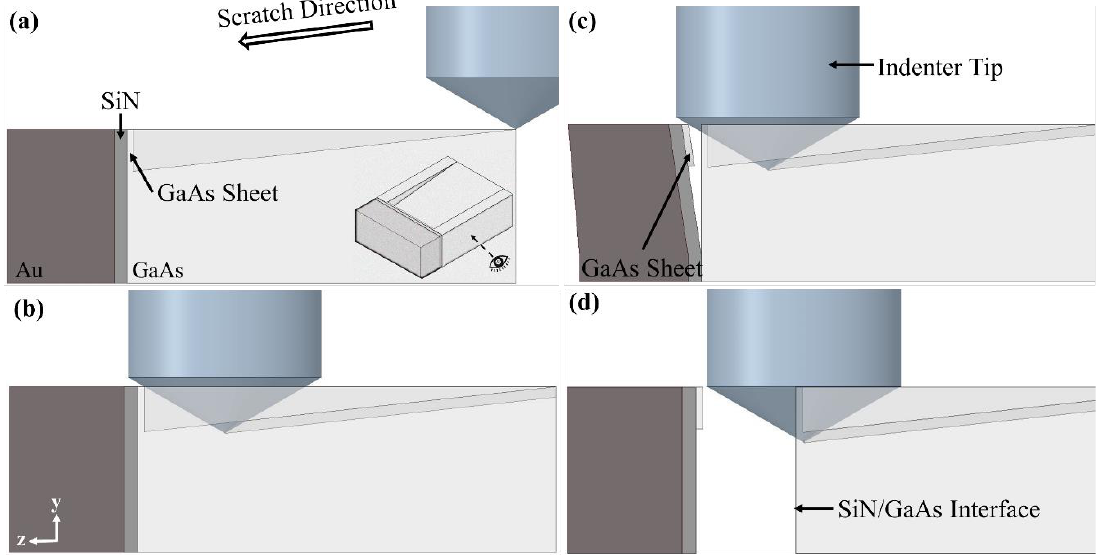
Figure 4. Schematic illustration of the push-out test: ( a ) indentation with normal load of 2 mN just outside the edge of the trench; ( b ) scratching along the central line of the trench until the indenter contacted the Au/SiN/GaAs panel; ( c ) fracture of the GaAs thin sheet and peeling of the Au/SiN panel off the GaAs base; and ( d ) complete detachment of the Au/SiN panel from the GaAs base.